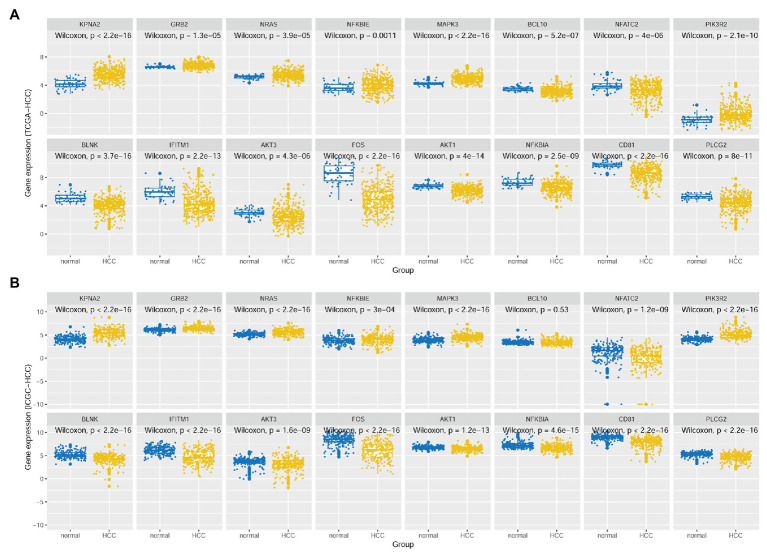
Expressional comparisons of KPNA2 and its correlated BCR signaling pathway genes between HCC tumors and normal livers. (A) Expressional differences of GRB2, NRAS, NFKBIE, MAPK3, BCL10, NFATC2, PIK3R2, BLNK, IFITM1, AKT3, FOS, AKT1, NFKBIA, CD81, and PLCG2 between HCC tumors and normal livers in the TCGA-HCC dataset. (B) Expressional differences of GRB2, NRAS, NFKBIE, MAPK3, BCL10, NFATC2, PIK3R2, BLNK, IFITM1, AKT3, FOS, AKT1, NFKBIA, CD81, and PLCG2 between HCC tumors and normal livers in the ICGC-HCC dataset. The x-axis and y-axis represented the sample groups and the relative expressions of the genes, respectively. The gene expressions were CPM normalized and log2(x + 0.001) transformed. BCR, B-cell receptor; CPM, count per million. Wilcoxon test was used for comparisons, and p < 0.05 was considered significant.